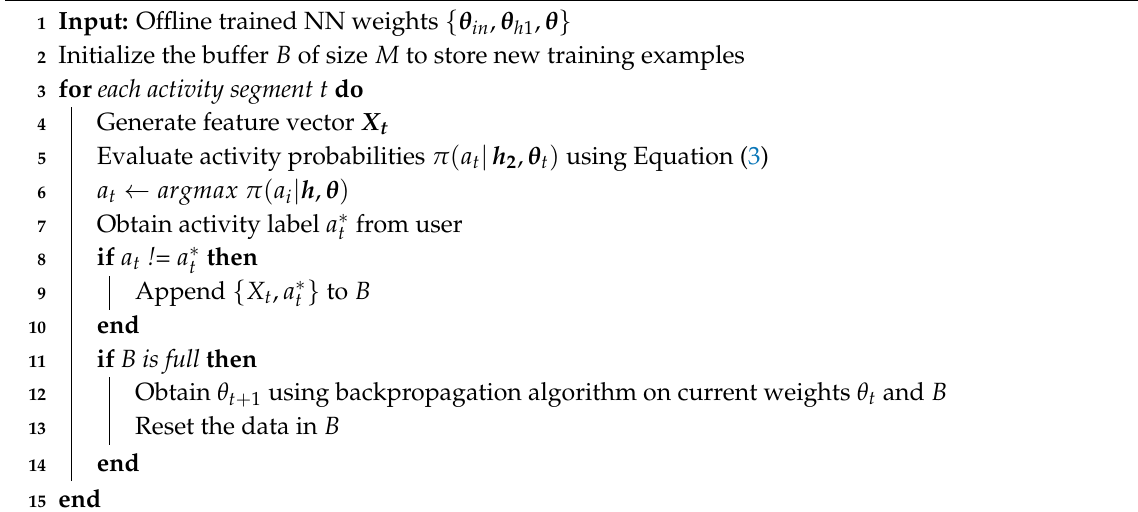
Algorithm 1: Weight Update via Supervised